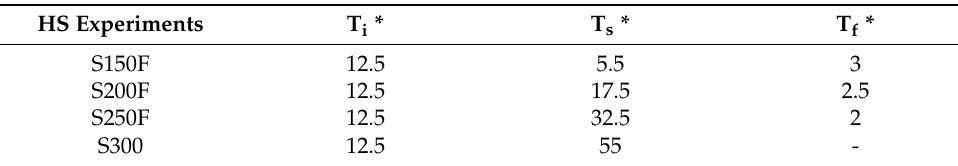
Table 3. Approximate times to reach operation temperatures. HS